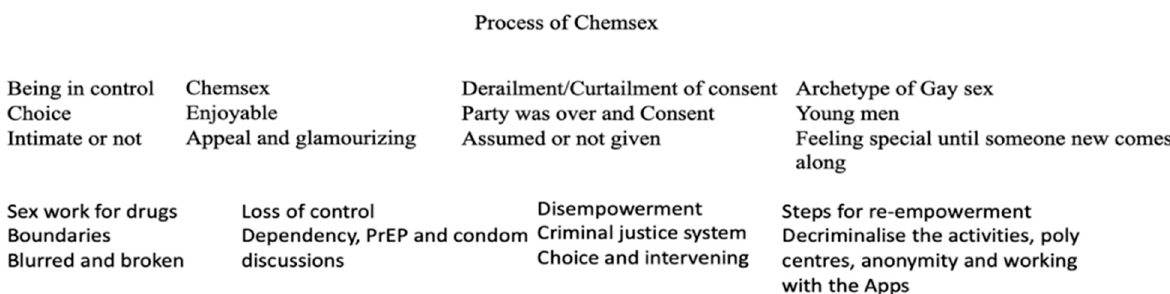
Figure 1. The Chemsex Consent Ladder—A Stepwise